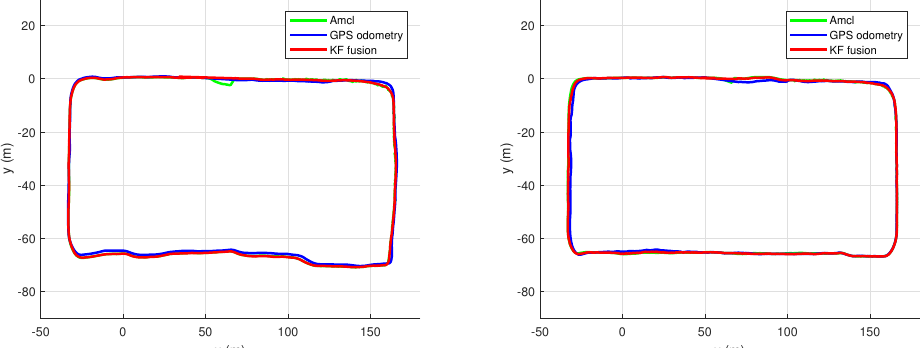
Figure 16. Trajectories through the R 3 path expressed by localization using the fusion described in Section 5. ( left ) Using GNSS standalone. ( right ) Using GNSS floating point. We see that in the case of the fusion with GNSS real-time kinematic RTK floating point ( right ), in the off-map area the fusion adapts to these observations.